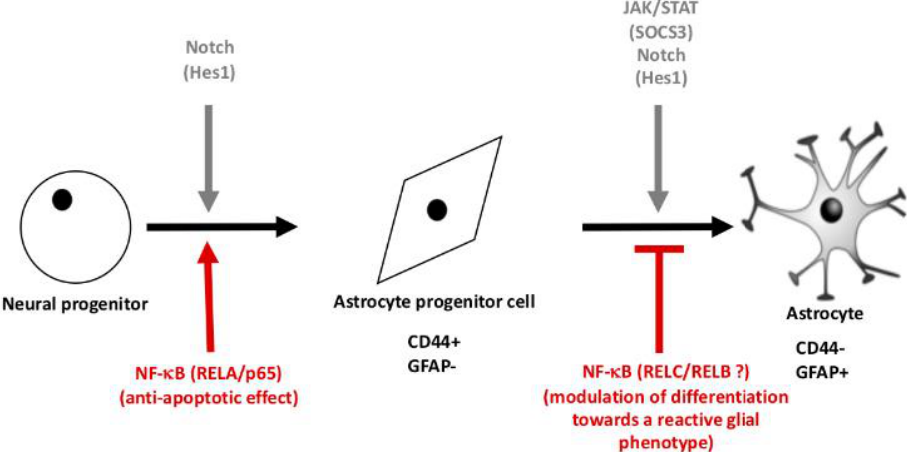
Figure 7. Proposed model for the role of NF-kB in the generation of astrocyte during neural stem cell